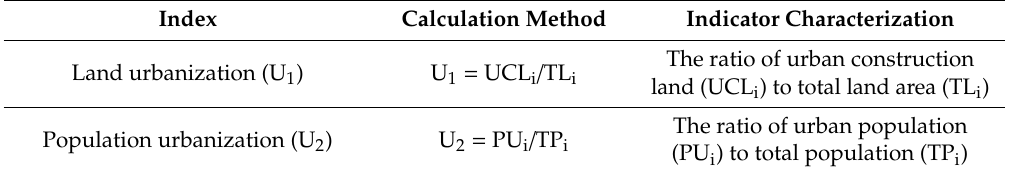
Table 1. Calculation and interpretation of the land-population urbanization